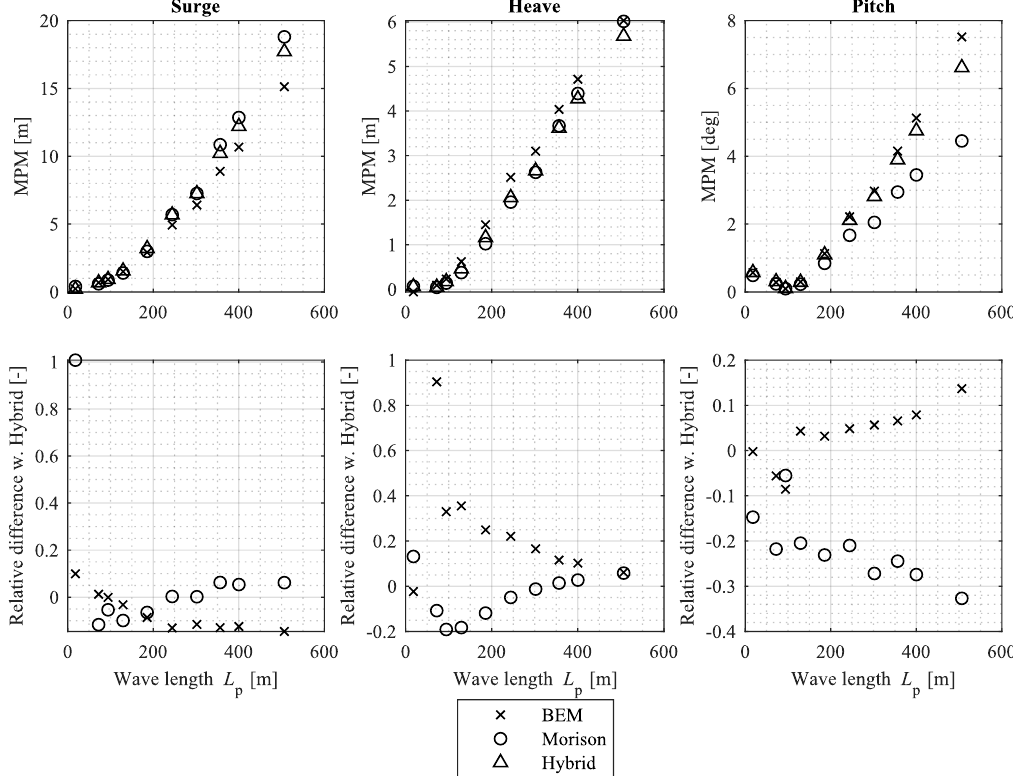
Figure 10. Top: Most probable maximum, MPM of the surge ( left ), heave ( middle ) and pitch ( right ) DoF with updated drag coefficients. The bottom figures illustrate the relative difference with the hybrid